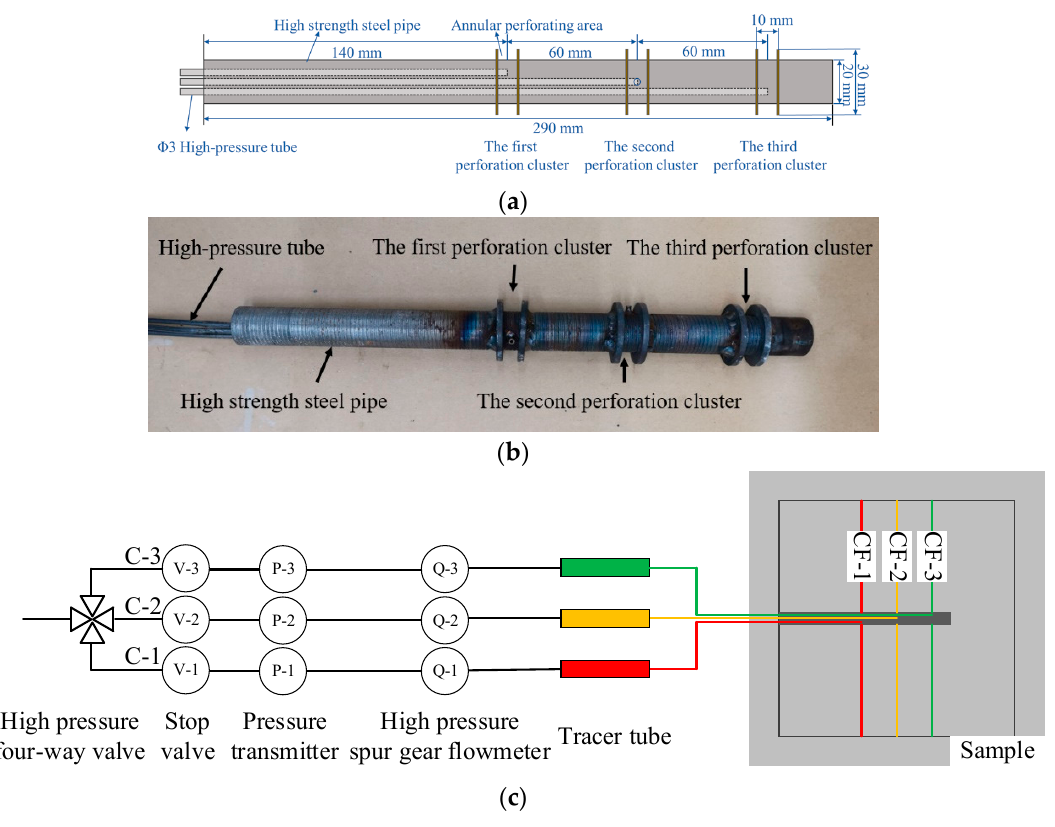
Figure 4. The design of multi-channel fracturing wellbore: ( a ) schematic diagram structure; ( b ) physical map; ( c ) working Figure 4. Thedesignofmulti-channelfracturingwellbore: ( a )schematicdiagramstructure; ( b )physicalmap; ( c ) working diagram. diagram.